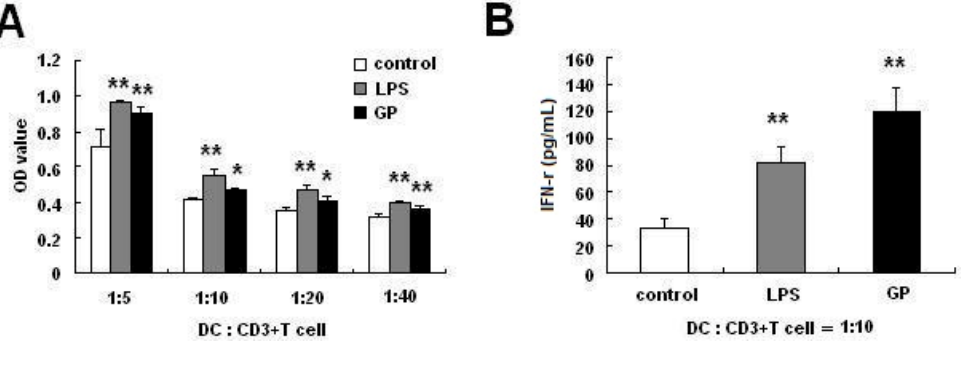
Figure 3. GP-treated DCs strengthen allogenic T cell proliferation and IFN- γ secretion. Day 6 BMDCs were stimulated with LPS (100 ng/mL) or GP (100 µg/mL) for 48 h. Allogeneic CD3+ T cell proliferation was measured after 5 days of co-culture with